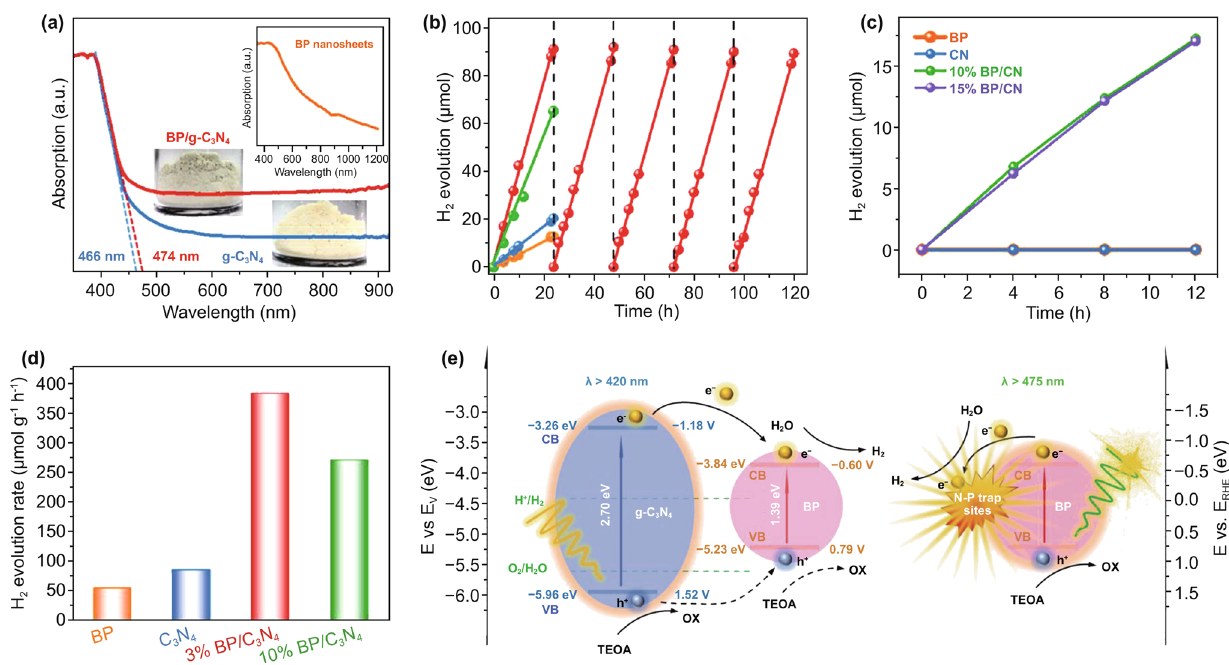
Fig. 8 BP/g-C 3 N 4 nanosheets with properties of high-quality, large lateral size and lower anomalous structural defects for high efficiency cata- lytic